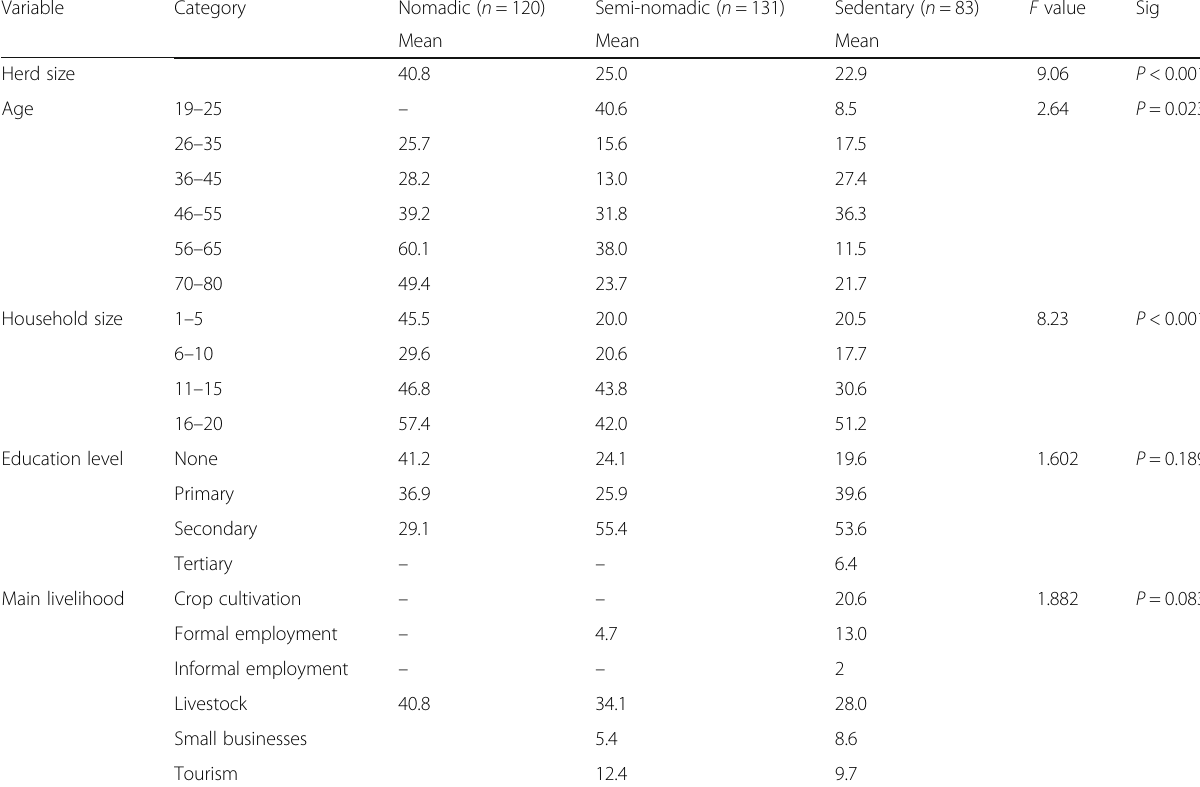
Table 1 Herd sizes (by tropical livestock unit (TLU)) aggregated by household socio-demographic attributes